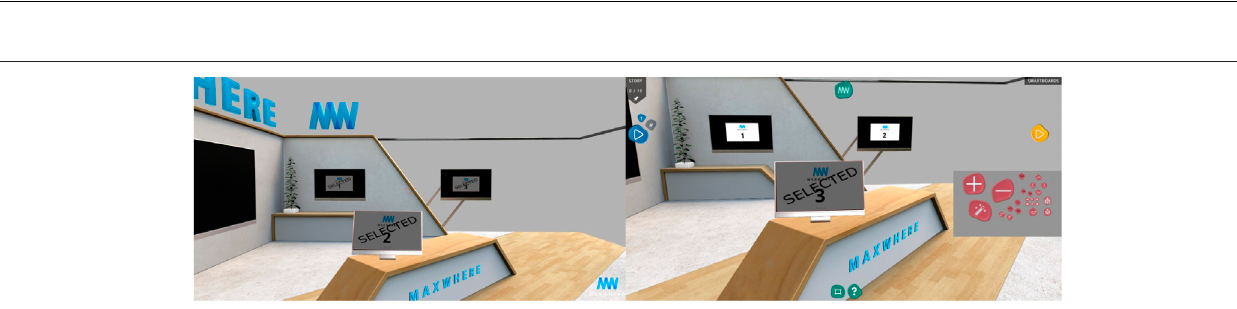
FIGURE 4 | Placement and addition of a new smartboard into the scene can be done by clicking the right mouse button to open the 2D “ pebbles ” menu and by clicking on the red plus sign.